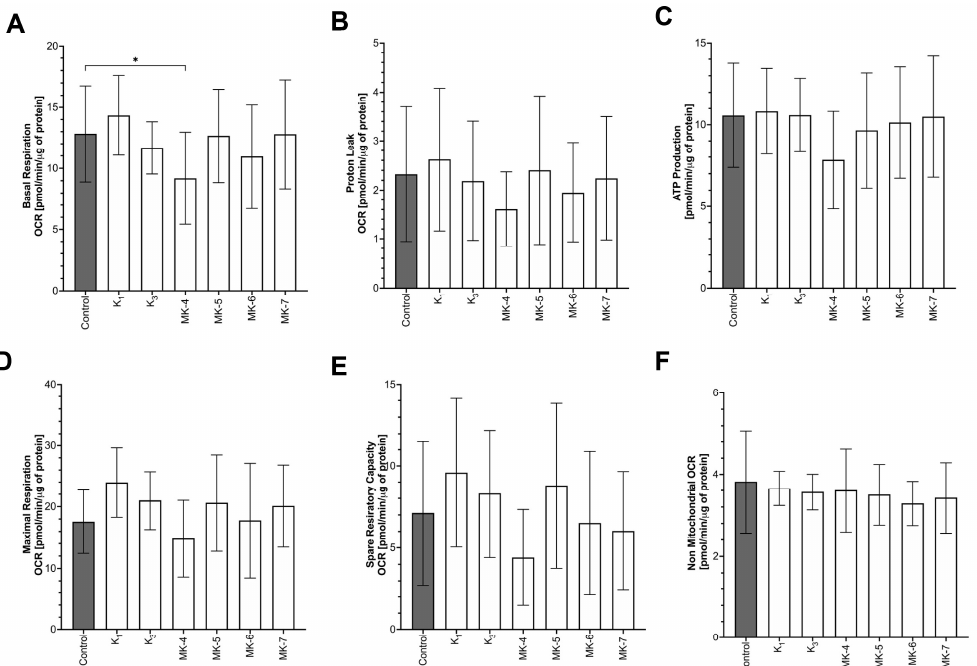
Figure 6 Figure 6. Effects of various forms of vitamins K on mitochondrial functions of RAW 264.7 cells. The mitochondrial function, in particular: basal respiration ( A ), proton leak ( B ), ATP production ( C ), maximal respiration ( D ), spare respiratory capacity ( E ) and non-mitochondrial oxygen-consumption ( F ) were analysed using the Seahorse method after 24 h incubation with various forms of vitamins K: K 1 , MK-4, MK-5, MK-6, MK-7 (10 µ M) and K 3 (1 µ M). Data are shown as means ± SD of four independent experiments with technical replicates excluding outliers ( n = 22–24). Statistical significance was evaluated by two-way ANOVA followed by Sidak’s post hoc multiple comparisons using GraphPad Prism 9 software. The symbol * indicates statistical significance at p <